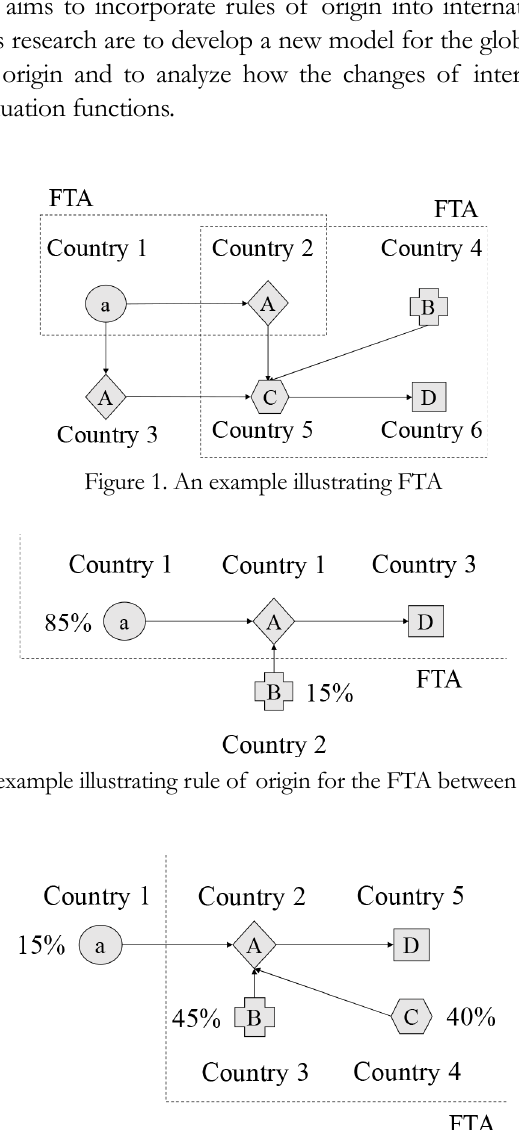
Figure 3 An example illustrating rule of origin for the FTA within a